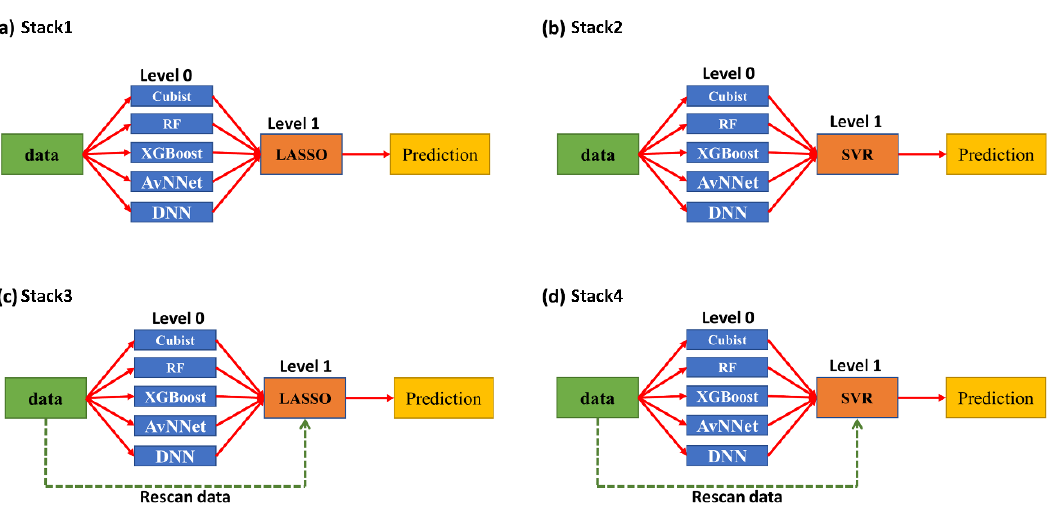
Figure 2. General framework of stacking approaches used in this study. ( a ) Cubist / Random Forests (RF) / extreme gradient boosting (XGBoost) / classical artificial neural network models (ANN) / neural network ensemble based on model averaging (AvNNet) / deep learning neural networks (DNN) + least absolute shrinkage and selection operator (LASSO); Stack1; ( b ) Cubist / RF / XGBoost / ANN / AvNNet / DNN + support vector regression (SVR); Stack2; ( c ) Cubist / RF / XGBoost / ANN / AvNNet / DNN + LASSO + rescan mode; Stack3; ( d ) Cubist / RF / XGBoost / ANN / AvNNet / DNN + SVR + rescan mode;